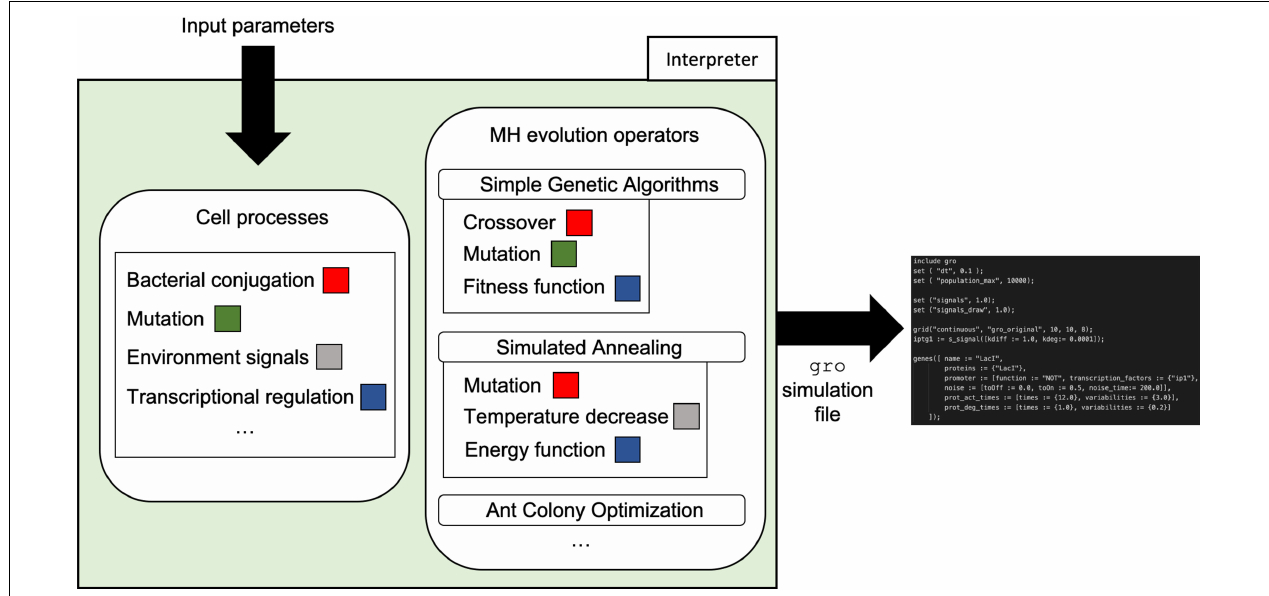
FIGURE 5 | Interpreter organization and workflow. The interpreter uses mappings from cell processes to specific MH evolution operators to automatically generate a gro simulation skeleton file. Input parameters such as conjugation rate, mutation rate, cell population values, among others, are used for the generation of the skeleton file according to gro